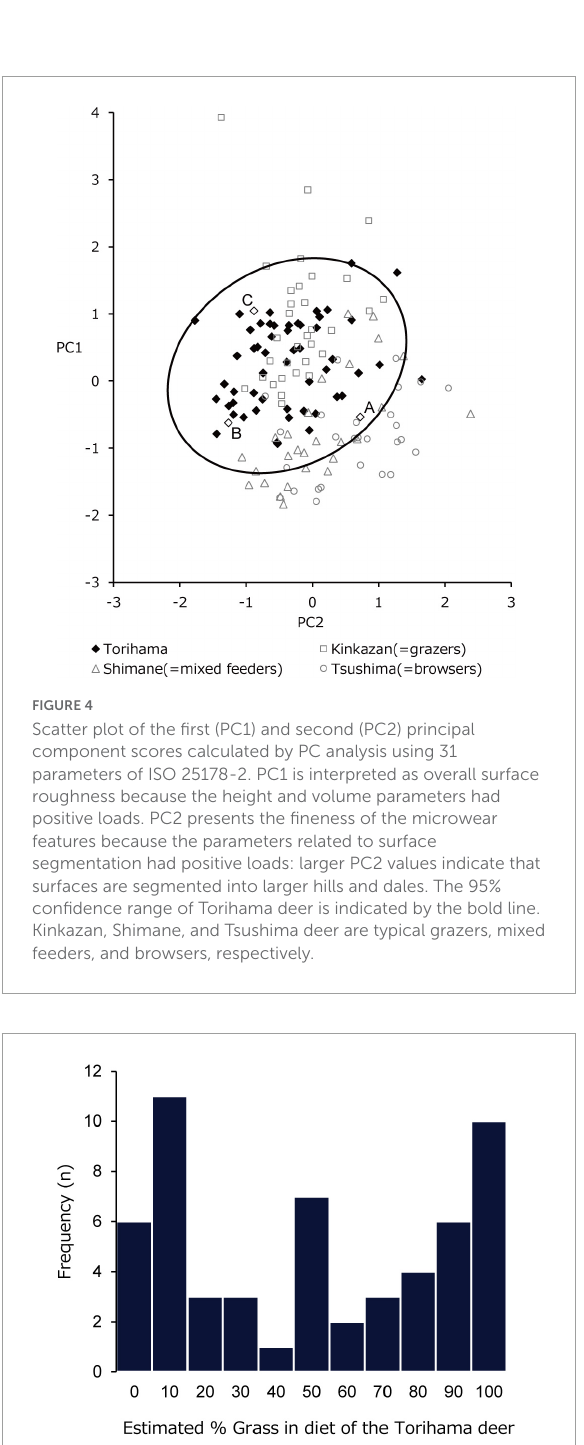
FIGURE5 Histogram of estimated % grass in the diet of the Torihama deer, using the estimation equation of Kubo and Fujita (2021).